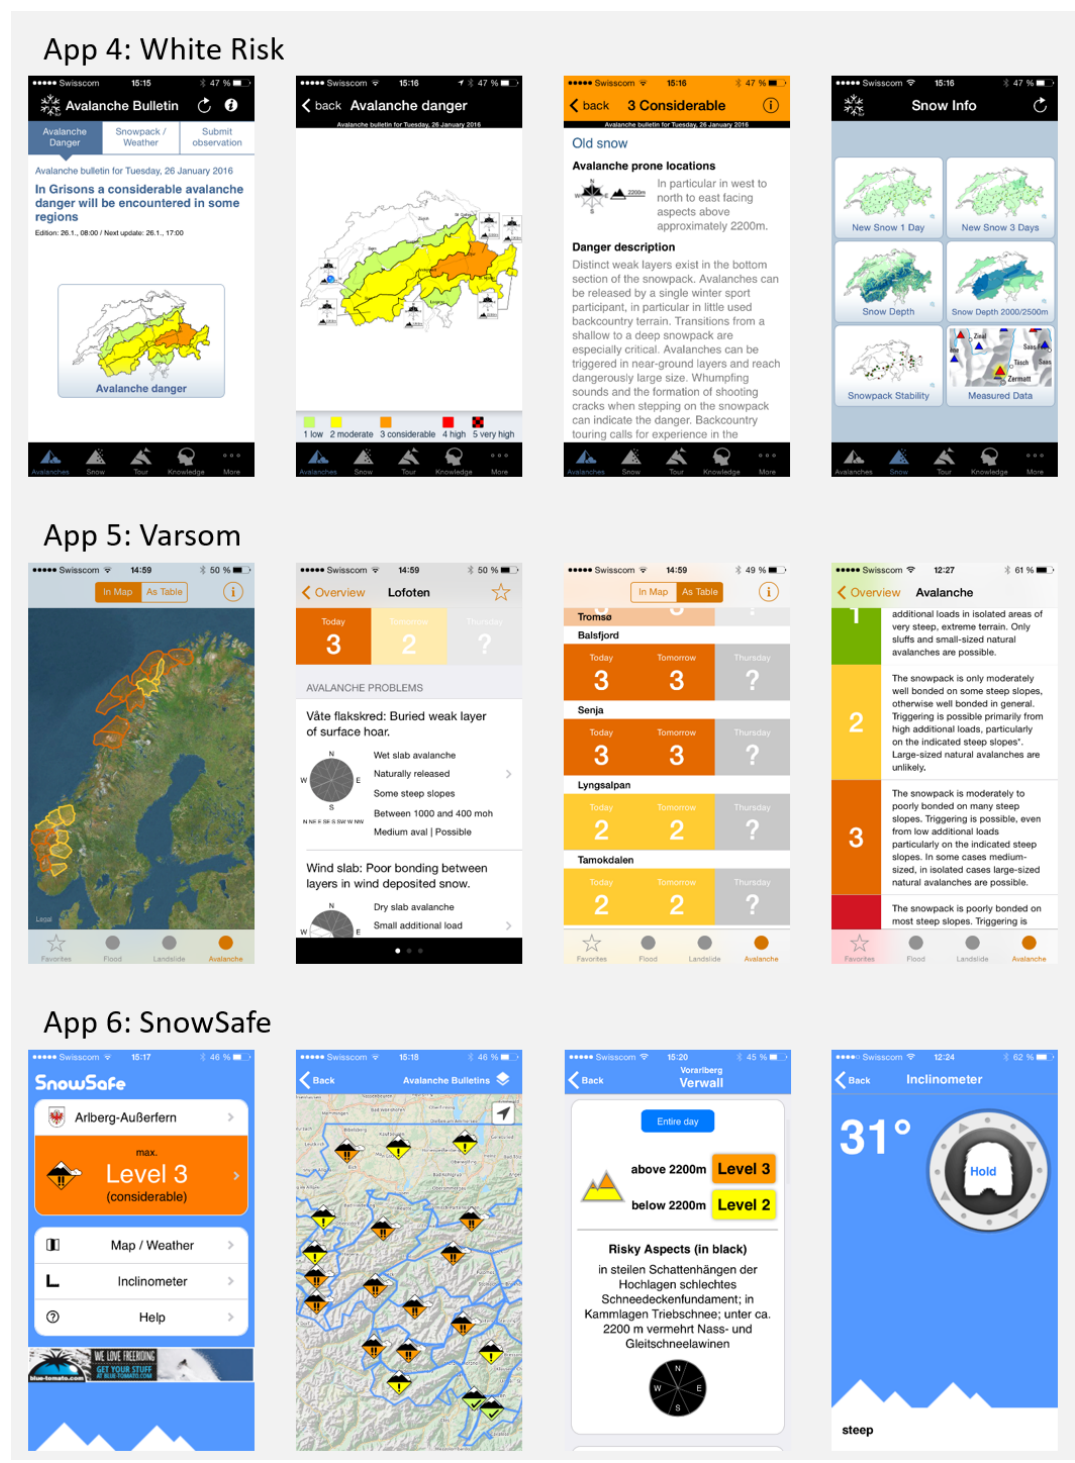
Figure 1. Screenshots of four pages of app 1 (Avalanche Canada), app 2 (Utah Avalanche Center), app 3 (Avalanche Forecast), app 4 (White Risk), app 5 (Varsom) and app 6 (SnowSafe). They were made on 26 January and 2 March 2016 on the versions of the apps that are compatible with IOS